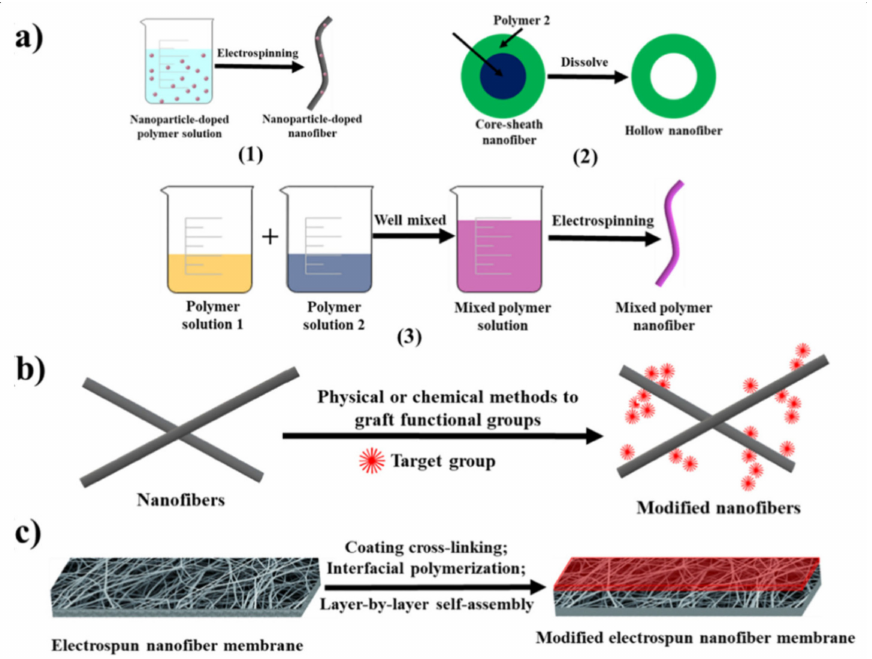
Figure 13. Schematic synthesis of composite nanofibers: ( a ) electrospinning of inorganic/organic polymer mixture, ( b ) surface modification of nanofibers and ( c ) LbL deposited nanofibers (reprinted with permission from ref.